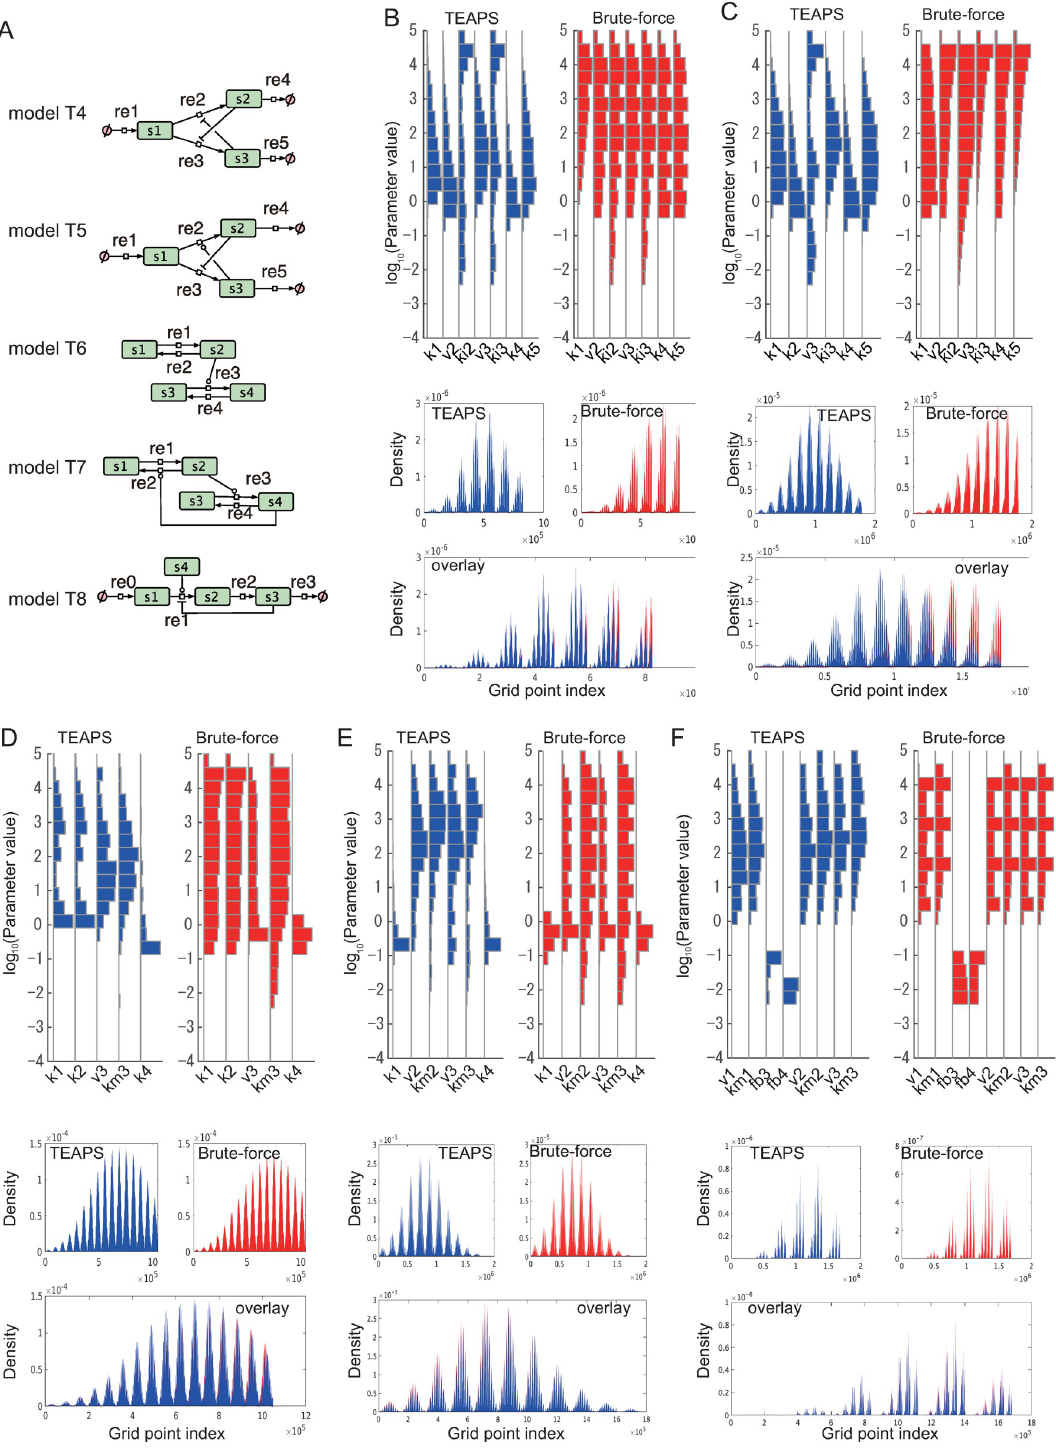
Fig 4. Performance assessment of TEAPS using various simple structure models. (A) Additional five sample models to be prepared for performance test. (B–F) Comparison of the TEAPS results and the brute-force search results for the models T4 (B), T5 (C), T6 (D), T7 (E) and T8 (F). The parameter sets satisfying the BSR condition were searched by TEAPS (upper left) or by the brute- force search (upper right), and the histograms of the distribution of the found parameter sets were compared. Density profiles of the found parameter sets were compared following the kernel density estimation (middle left: TEAPS, middle right: brute-force search). Two density profiles were overlaid (bottom).